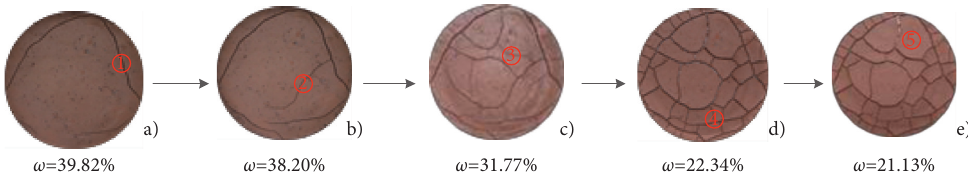
Figure 6: Crack development of Sample 1 during drying. Figure 6 mainly expresses the evolution process of fractures. It is observed that the main fracture appears at first, and then a secondary fracture appears in the direction perpendicular to the main fracture, continues, and finally evolves into the network fracture shape in Figure 6(e). (a) w � 39.82%. (b) w � 38.20%. (c) w � 31.77%. (d) w � 22.34%. (e) w �